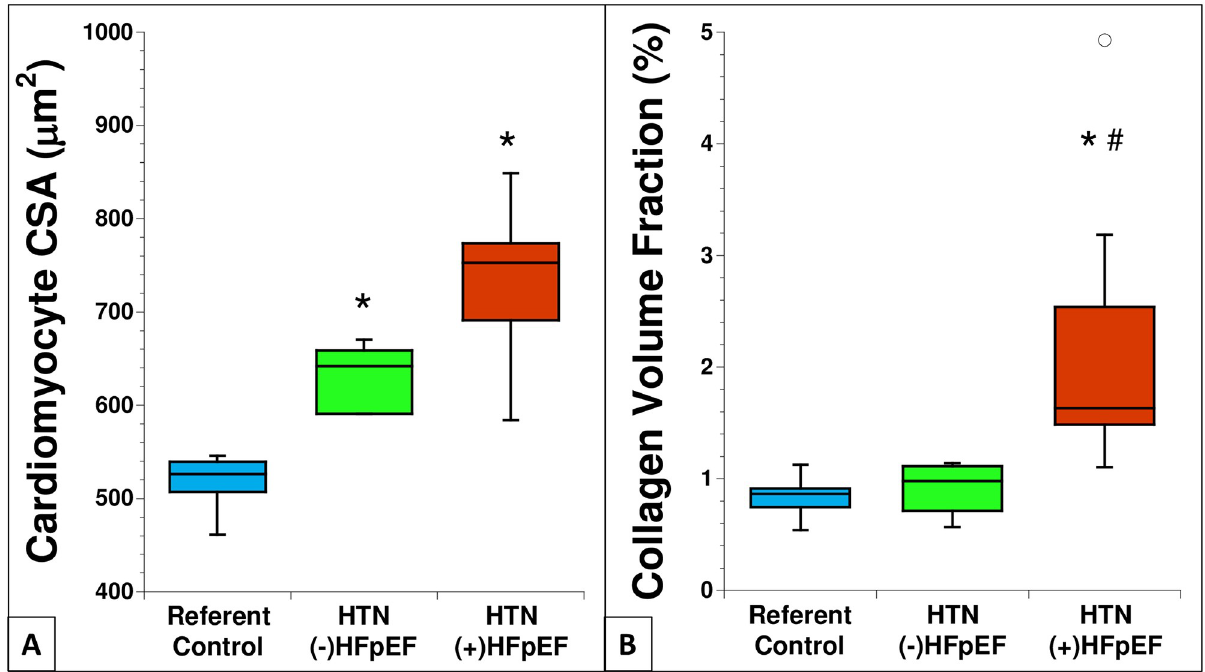
Fig 2. A) Quantification of cardiomyocyte CSA (Blue: Referent control (n = 7), Green: HTN (-) HFpEF (n = 6), Red: HTN (+) HFpEF (n = 12)). B) Quantification of collagen volume fraction (Blue: Referent control (n = 7), Green: HTN (-) HFpEF (n = 6), Red: HTN (+) HFpEF (n = 12)). � p < 0.05 versus referent control; #p < 0.05 versus HTN (-) HFpEF. Open circles represent outlier